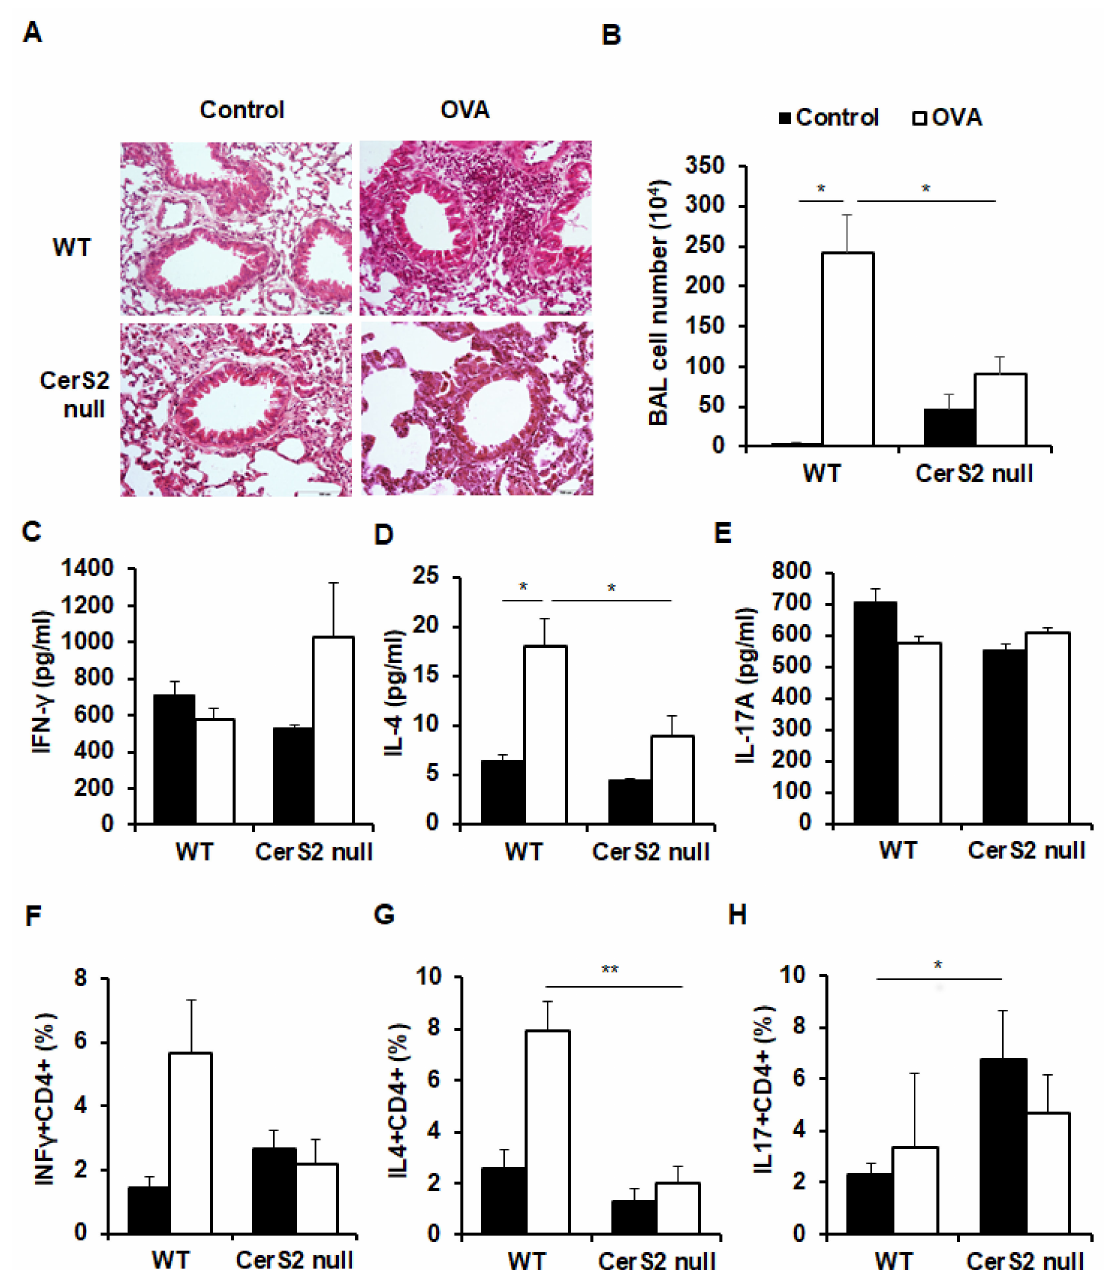
Figure 1. Wild type (WT) and ceramide synthase 2 (CerS2) null mice exhibit different immune responses in airway inflammation. ( A ) Paraffin-embedded lung sections were prepared 24 h after the last ovalbumin (OVA) or phosphate- buffered saline (PBS) challenge, then stained with hematoxylin and eosin to visualize inflammation (magnification: × 200). ( B ) Bronchoalveolar lavage (BAL) fluid was collected 24 h after the final ovalbumin or PBS challenge, and the number of cells in the BAL fluid was determined. Protein levels of ( C ) interferon- γ (IFN- γ ), ( D ) interleukin (IL)-4, and ( E ) IL-17 in the BAL fluid were measured using ELISA. Helper T (Th) cell profiles were compared by measuring ( F ) CD4 (cluster of differentiation 4)+ IFN- γ + Th1 cells, ( G ) CD4+ IL-4+ Th2 cells, and ( H ) CD4+ IL-17+ Th17 cells using flow cytometric analyses. Data are means ± SEM ( n = 6). * p < 0.05; ** p < 0.01. Statistical significance was analyzed using the two-way analysis of